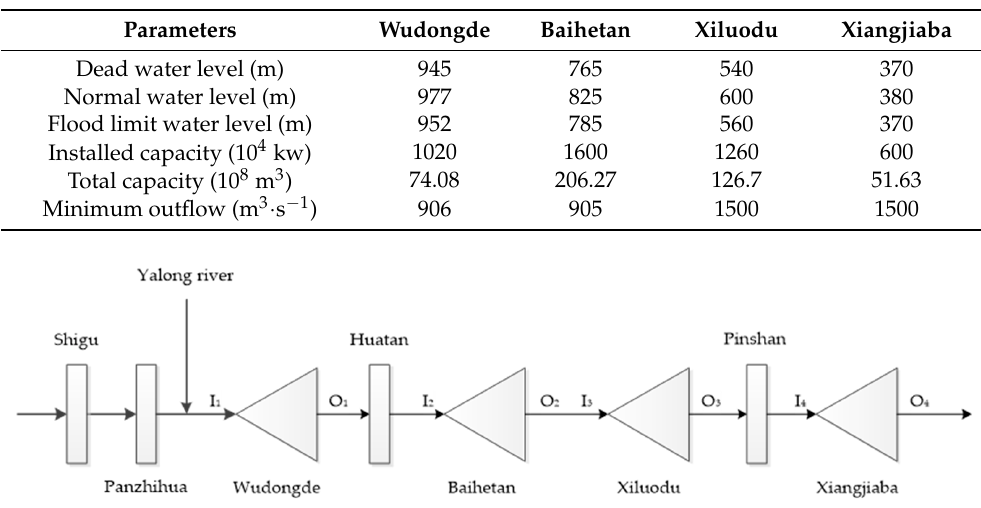
Figure 13. Topology of hydrological stations in the Jinsha River. There are two hydrological stations in the basin—Huatan and Pinshan, and the streamflow of the four hydropower stations was projected using the Xinanjiang